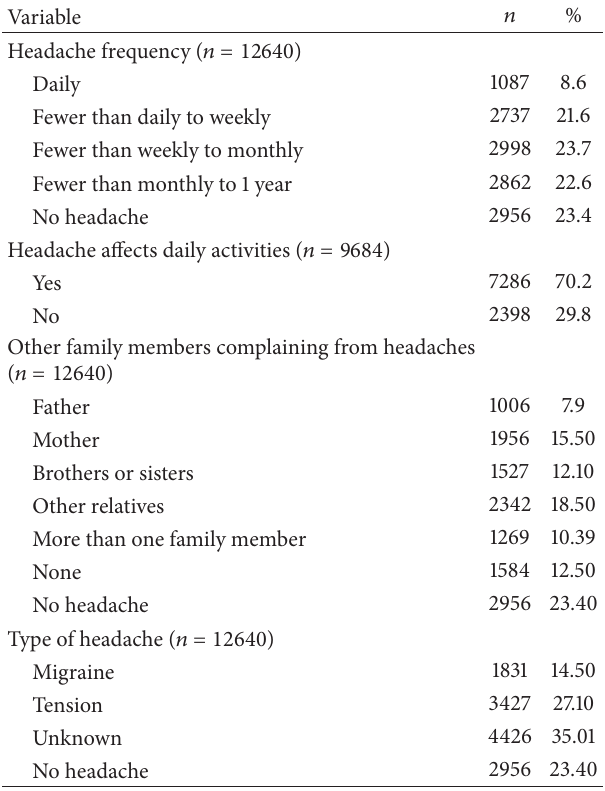
Table 2: Family history, frequency and type of